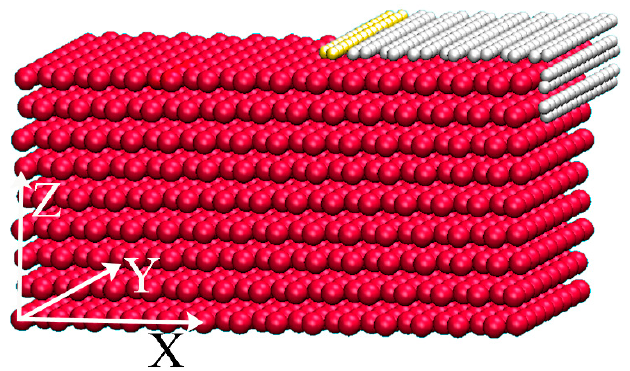
Figure 1. Schematic of a grain boundary with a quarter-turn shape covered by a piece of graphene sheet containing 290 C atoms.